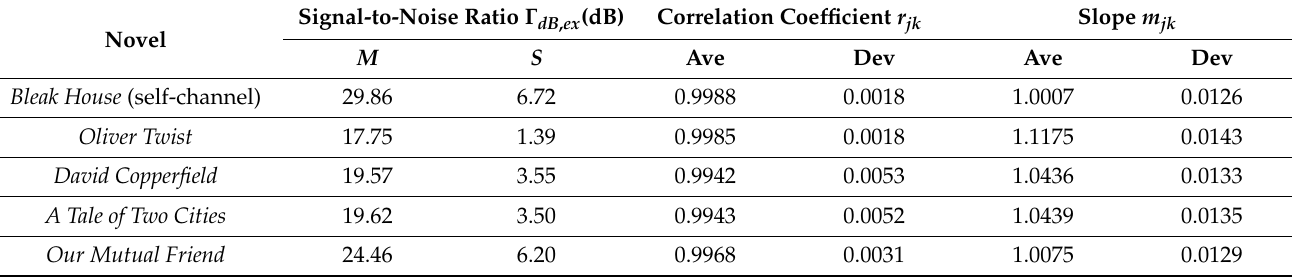
Table 7. Average value M (dB) and standard deviation S (dB) of Γ dB , ex (dB) in self- and cross-channels, correlation coefficient r jk , and slope m jk of the regression line between the number of sentences n S of Bleak House (channel output, self-channel) versus the number of sentences n S in the other Dickens novels (channel input, cross-channels), for equal number of words, in the sentences